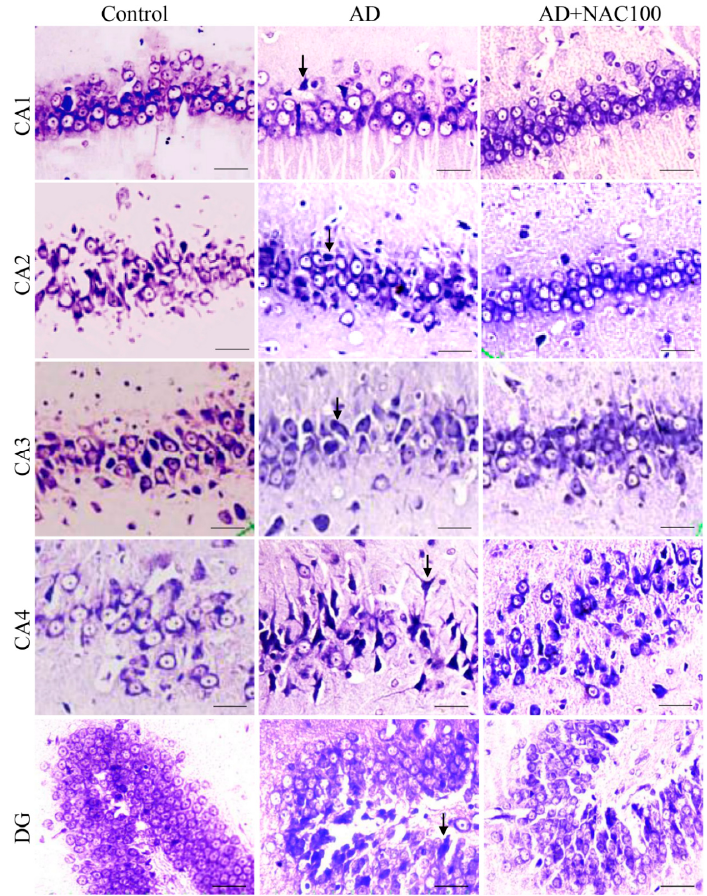
Figure 3. Photomicrographs of the hippocampal sub regions in different groups of rats stained with cresyl violet stain. Note the degenerating neurons (Arrow) in AD group in all the regions. No such degenerating neurons were observed in AD + NAC treated groups in any region. (Photomicrographs of Sham and AD + NAC 50 groups are avoided for simplicity). Scale bar = 20 µ, in CA1-CA4 regions, =15 µ in dentate gyrus (DG).